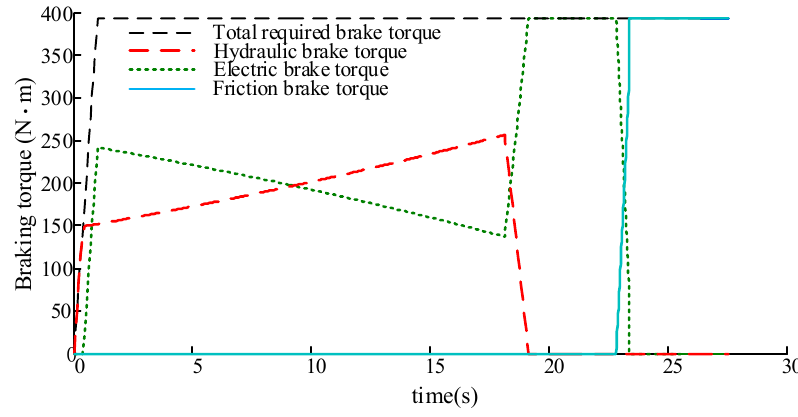
Figure 12. Brake torque distribution and its variation in the front axle.